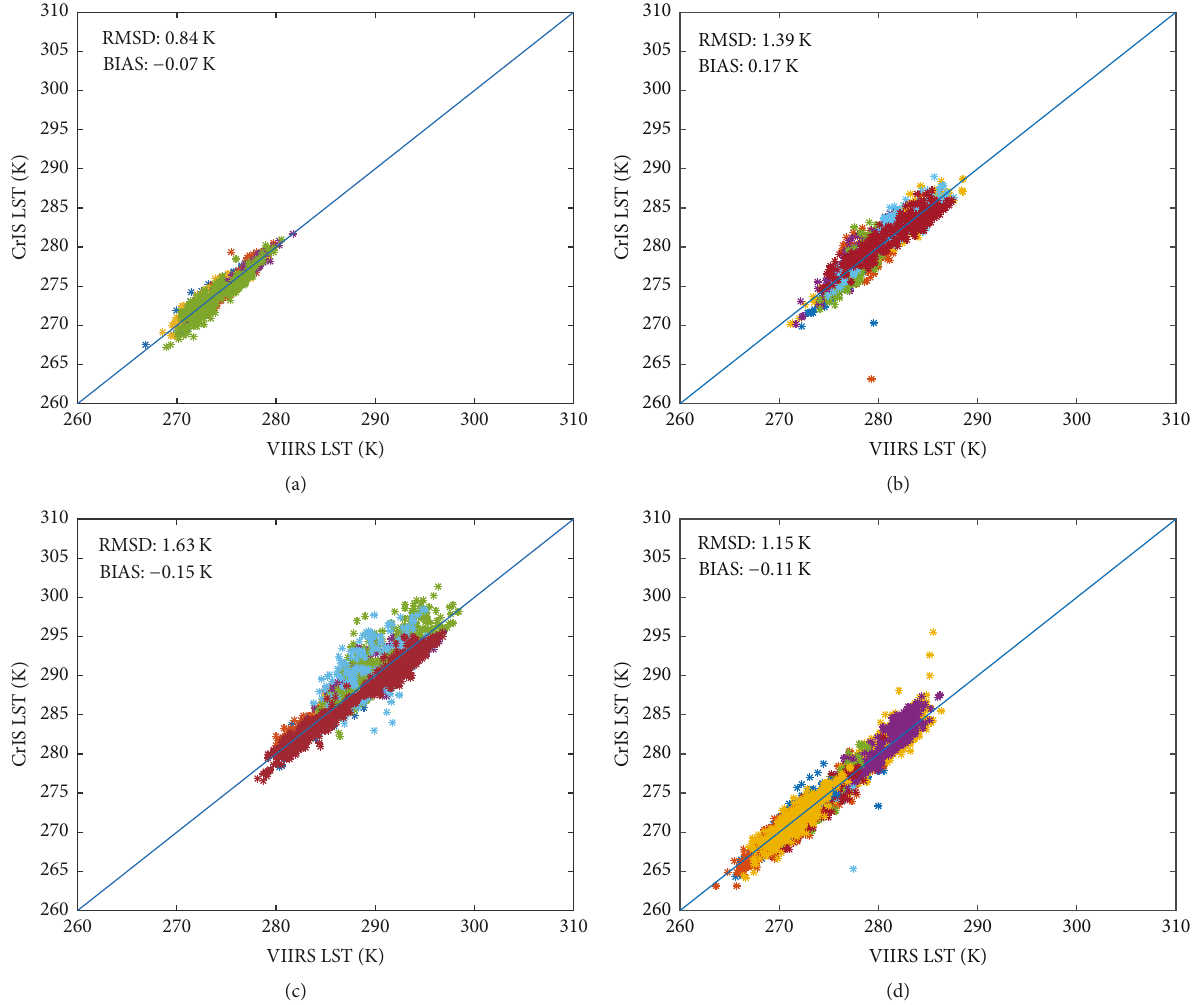
Figure3:ResultsofretrievedLSTsfromCrISdatain2differentmonths,2013.Differentcolorsindicatethedifferentdays:(a)LSTsinFebruary;